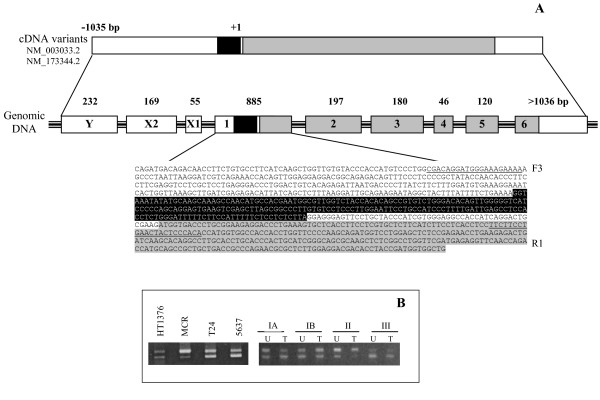
The two ST3Gal.I transcripts are expressed in the majority of the bladder cancer and urothelium cells. A: Schematic diagram of human ST3Gal.I cDNA (on the top) and genomic (on the centre) sequences. The black rectangle in ST3Gal.I cDNA represents the sequence which is present in ST3Gal.I transcript variant NM_003033.2 and absent on the transcript variant NM_173344.2. Exons containing the coding region (represented in grey) are denoted as 1-6 with the sizes shown above. The total of exon 1 nucleotide sequence is shown below: DNA sequence absent in transcript variant NM_173344.2 is represented on black background and the location of the primers F3 and R1 used to discriminate the transcript variants is underlined. B: RT-PCR analysis of NM_003033.2 and NM_173344.2ST3Gal.I transcripts in bladder cancer cell lines and patient's specimens. The ST3Gal.I exon 1 was amplified in cDNAs obtained from HT1374, MCR, T24 and 5637 bladder cancer cell lines and bladder tumor (T) tissue and corresponding normal urothelium (U) from 6 randomly chosen patients (subgrouped as described above), using F3 and R1 primers. The predicted sizes of the products are 609 bp (NM_003033.2) and 406 bp (NM_173344.2).